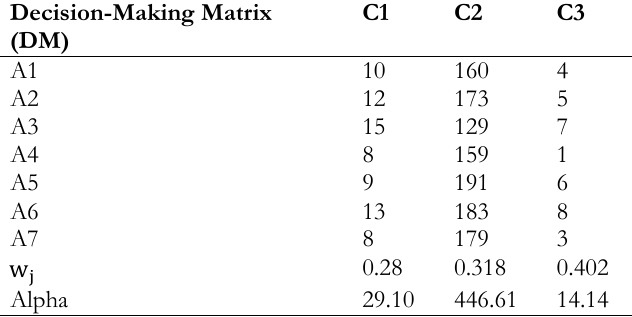
Table 22. Collective matrix of expert opinions.